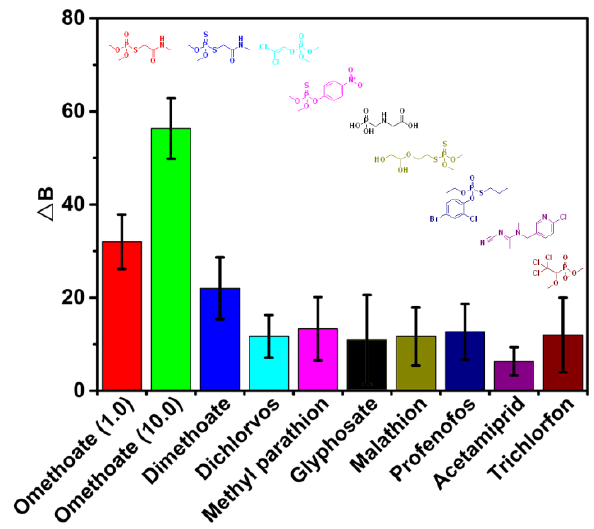
Figure 4. Specificity analysis of the developed colorimetric sensor.